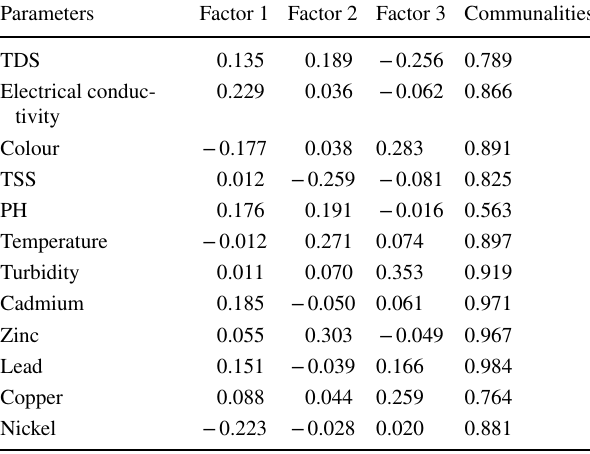
Table 4 Factor analysis for the dry spell